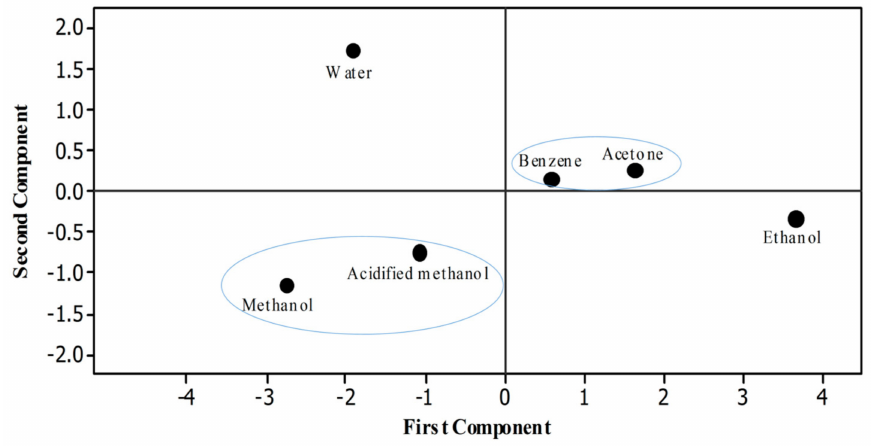
Figure 4. Score plot. Table 5. Correlation between different properties of rye